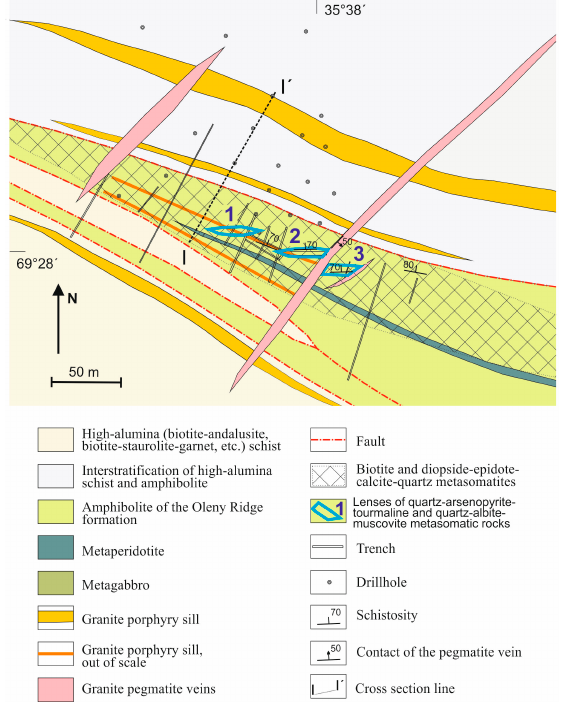
Figure 9. Schematic geological map of the Oleninskoe deposit, modified from references [28,37].